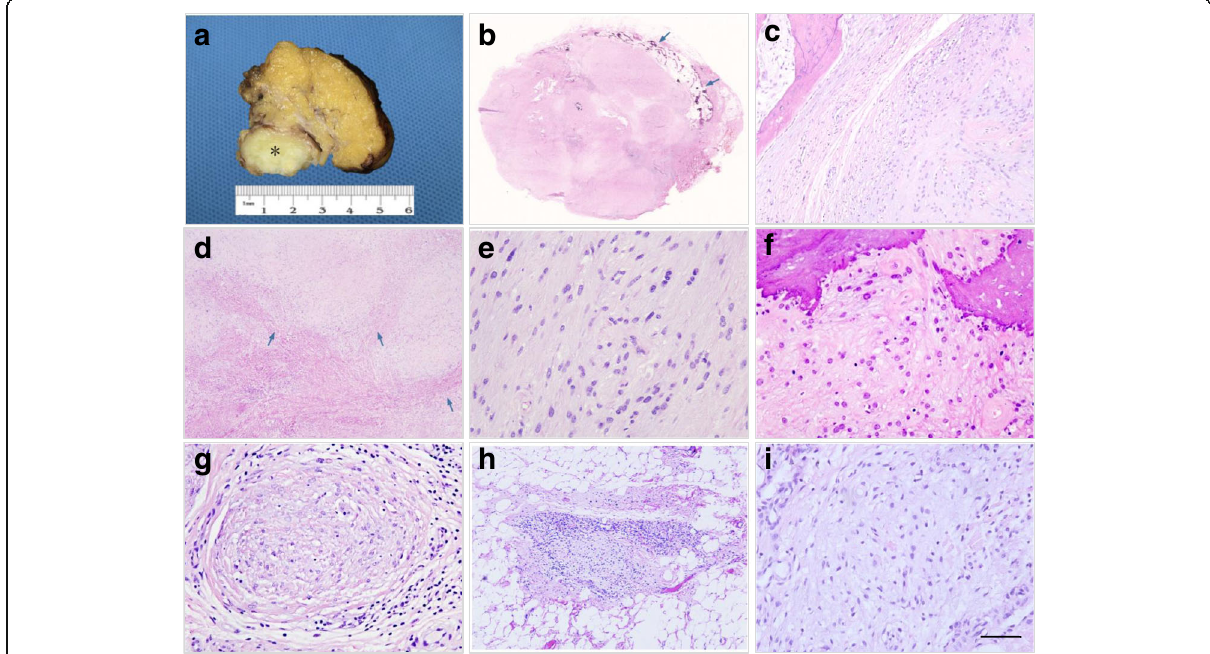
Fig. 3 Ossifying fibromyxoid tumor. The cut surface of the tumor is oval, gray-white and well-demarcated from the adjacent soft tissues with delicate fibrous septa (asterisk indicates) ( a ). The tumor is associated with a peripheral shell of metaplastic bone (arrows indicate) ( b , c ). Fibrous septa can be seen from the capsule into the neoplasm, separating them into cellular islands ( d ). Cells in this case are typically uniform, they are polygonal or spindle shape with fibromyxoid-appearing matrix ( e ). Clusters of calcification are within the tumor ( f ). Nodules of tumor cells can be seen outside of the capsule ( g ). Sections of the soft tissues adjacent to the tumor show clusters of tumor cells ( h , j ). Scale bar: 250 μ m ( d ),